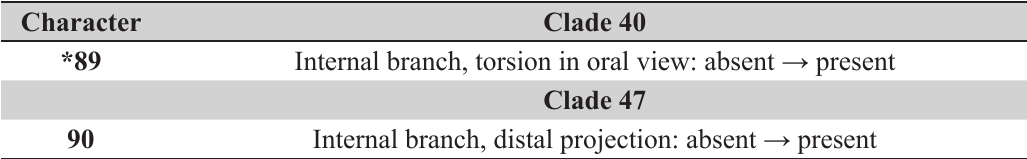
Table 7. List of characters recovered to support the clade 40 and 47 from the cladistic analysis (see Fig. 4). Only discrete characters are shown. Characters marked with an asterisk (*) are homoplastic synapomorphies.